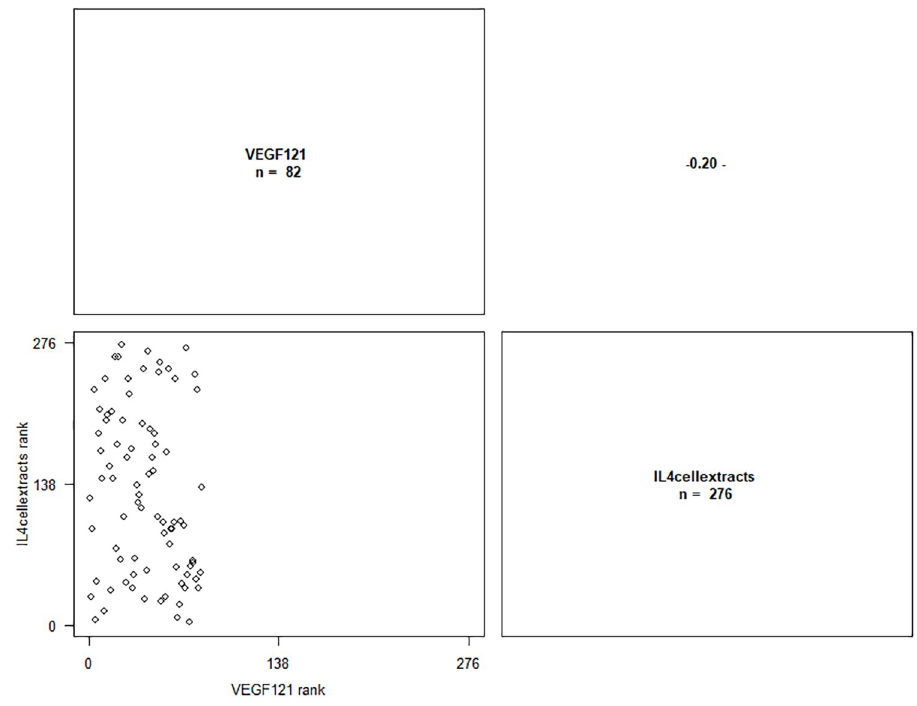
Fig 3. Correlation graph between VEGF 121 isoform mRNA levels and IL-4 cellular extracts levels. ‘-’ p � 0.1.